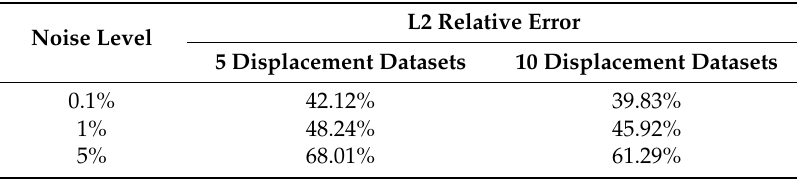
Table 3. Relative L2 error for the cases presented in Figures